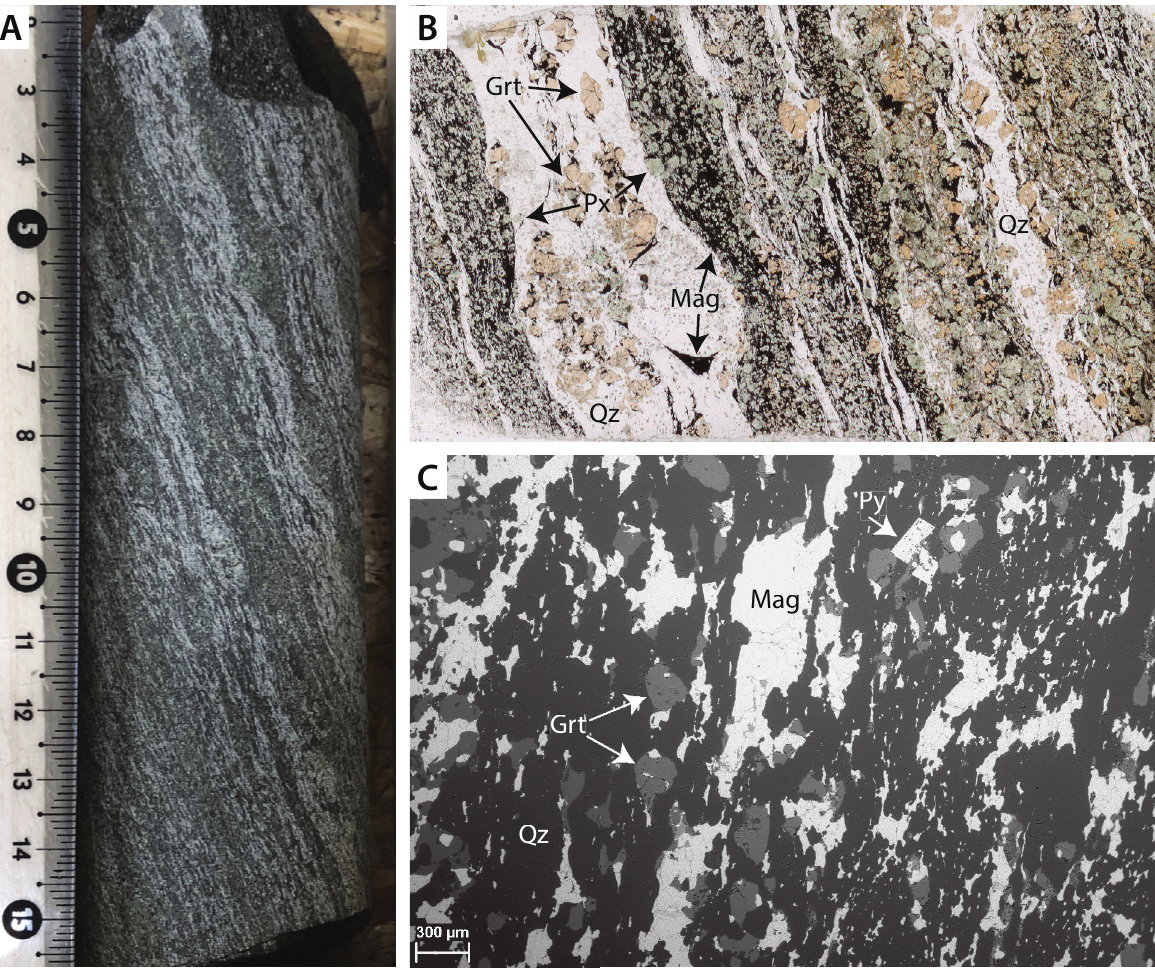
Fig. 3. A , an example of drill core with banded texture typical of magnetite quartzites in the Jõhvi iron formation, drill core Jõhvi PA­2, depth 482.65­482.8 m. Photomicrographs of quartz layers alternating with interlayers of dark minerals in foliated magnetite quartzites ( B , plane­polarized light, drill core F1, depth 347.3 m; C , scanning electron microscope, drill core Jõhvi PA­1, depth 511.0 m). Qz, quartz; Grt, garnet; Px, pyroxene; Mag, magnetite; Py,